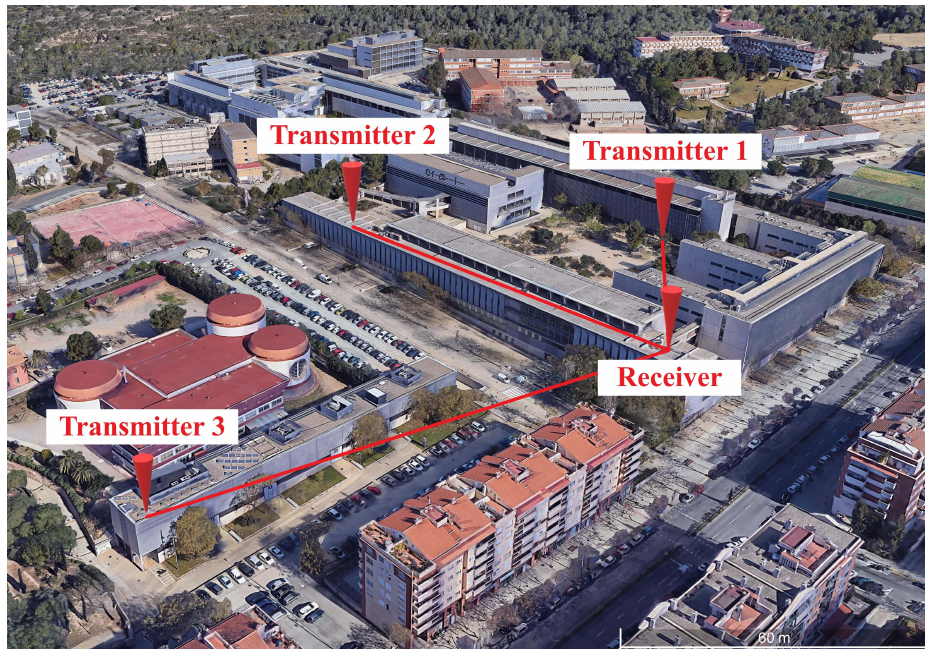
Figure 2. LoRa transceiver deployment.